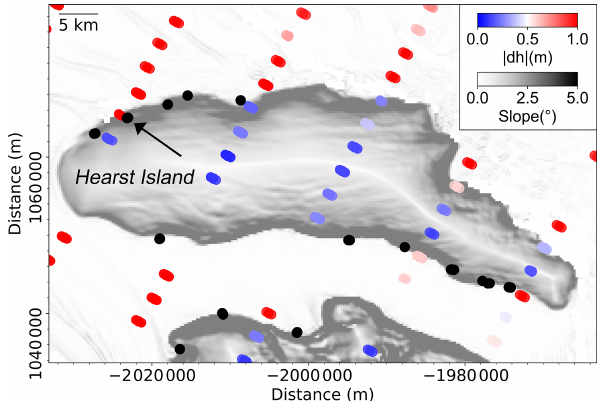
Figure 9. Spatial distribution of ICESat-2 crossovers in Hearst Is- land. The absolute change in elevation at each crossover, | d h | , is shown as the colour-coded dots. ICESat-2-derived inland limit of tidal flexure (Point F) is shown as black dots. Background is the sur- face slope from the REMA DEM with a 250m resolution (Howat et al., 2019) in Antarctic polar stereographic (epsg:3031)